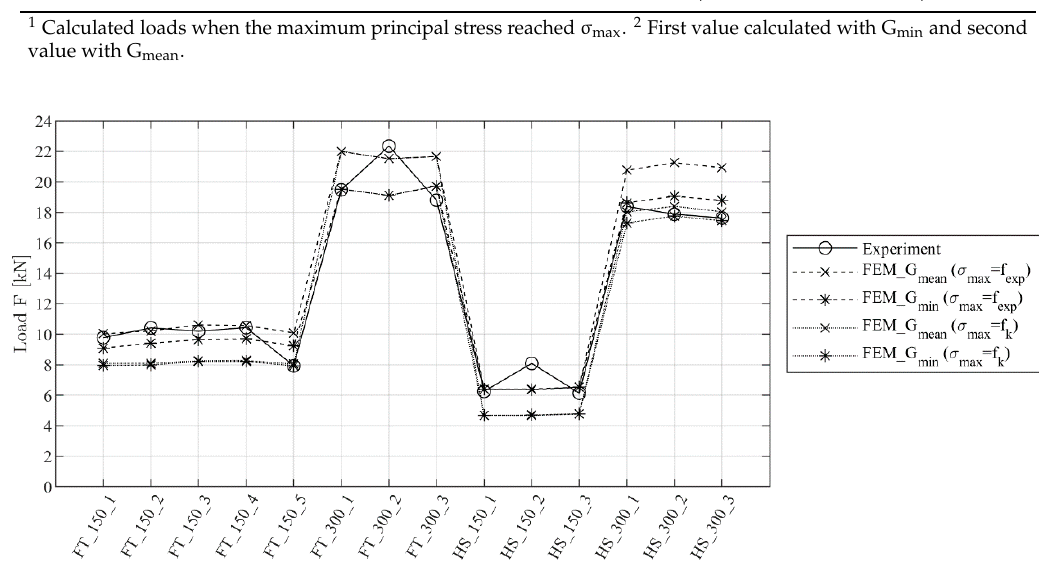
Figure 8. Comparison of the ultimate loads.